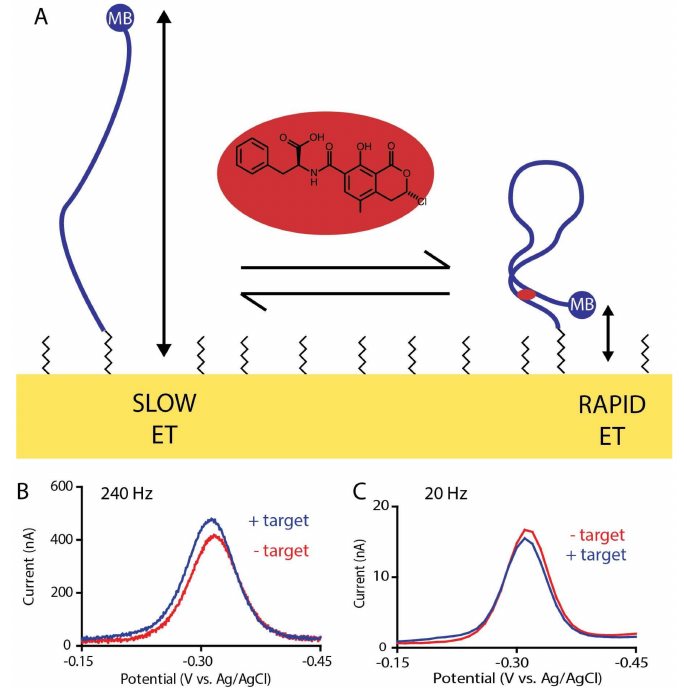
Figure 1. ( A ) The ochratoxin A-detecting E-AB sensor consists of an ochratoxin A-binding DNA aptamer modified attached via its 5 (cid:48) end to a gold electrode using a six-carbon thiol linker (which forms part of a self-assembled monolayer) and modified on its 3 (cid:48) end with a methylene blue redox reporter (blue circle, “MB”). The binding of ochratoxin A (red oval) alters the aptamer’s conformation, changing in turn the rate of electron transfer in a manner easily monitored using square wave voltammetry [10]. ( B ) At higher square wave frequencies square wave voltammetry is more sensitive to rapid electron transfer and, thus, target addition increases the observed current. ( C ) At lower frequencies, in contrast, target addition decreases the observed